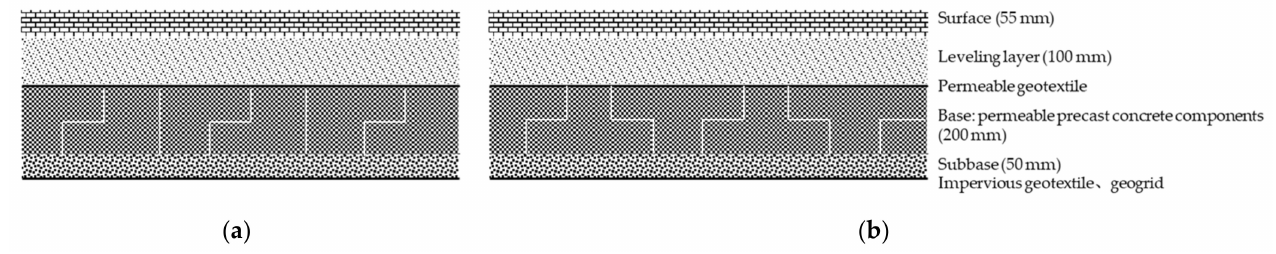
Figure 1. Permeable pavement model used in the study: ( a ) precast concrete in type a; and ( b ) precast concrete in type